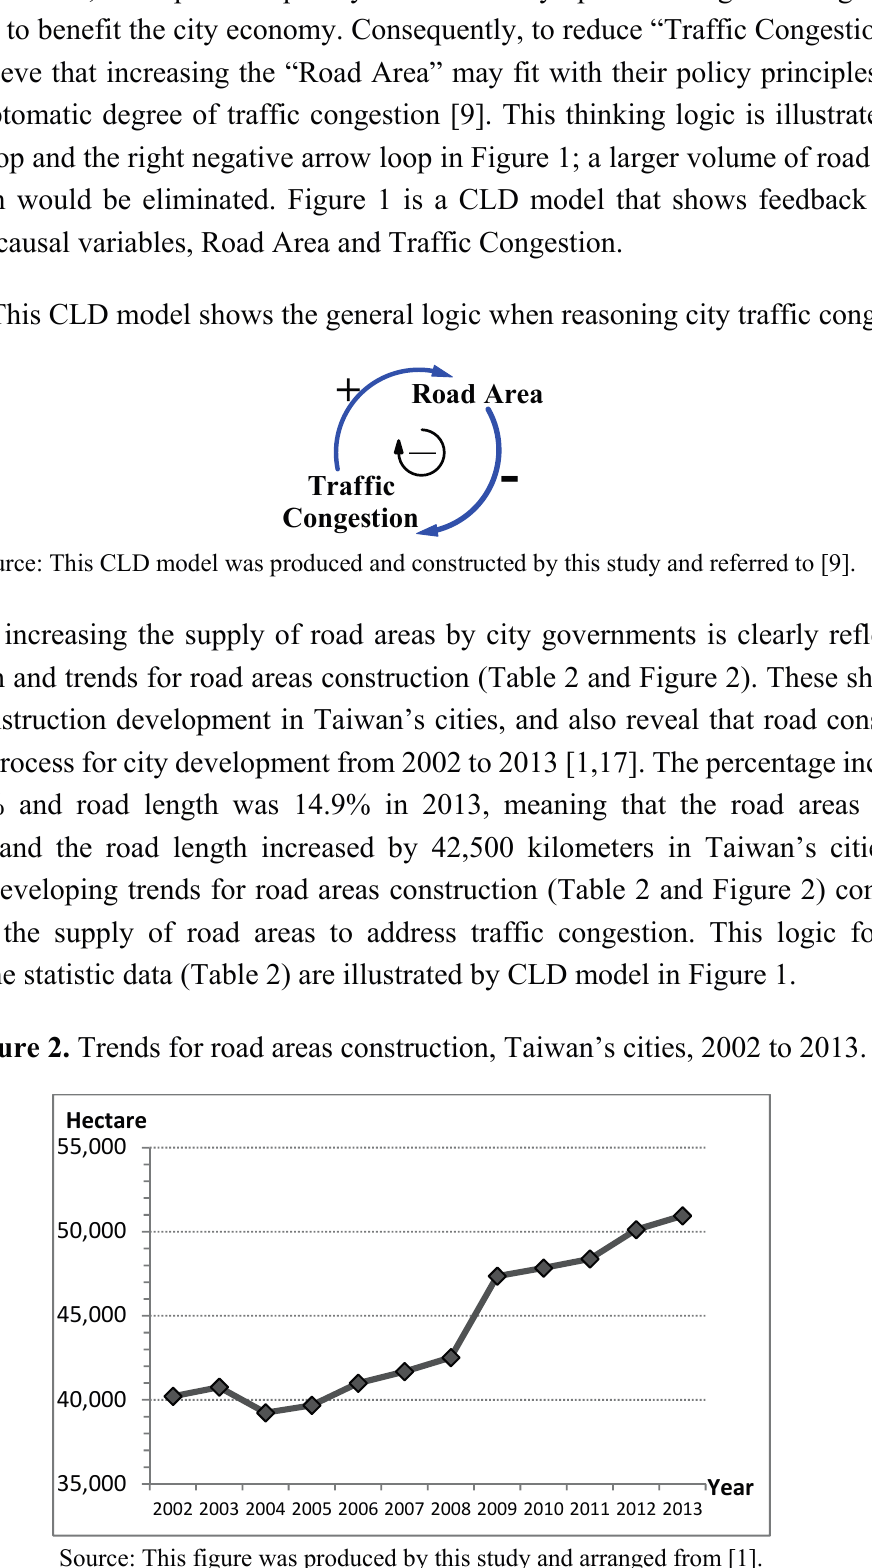
Source: This figure was produced by this study and arranged from